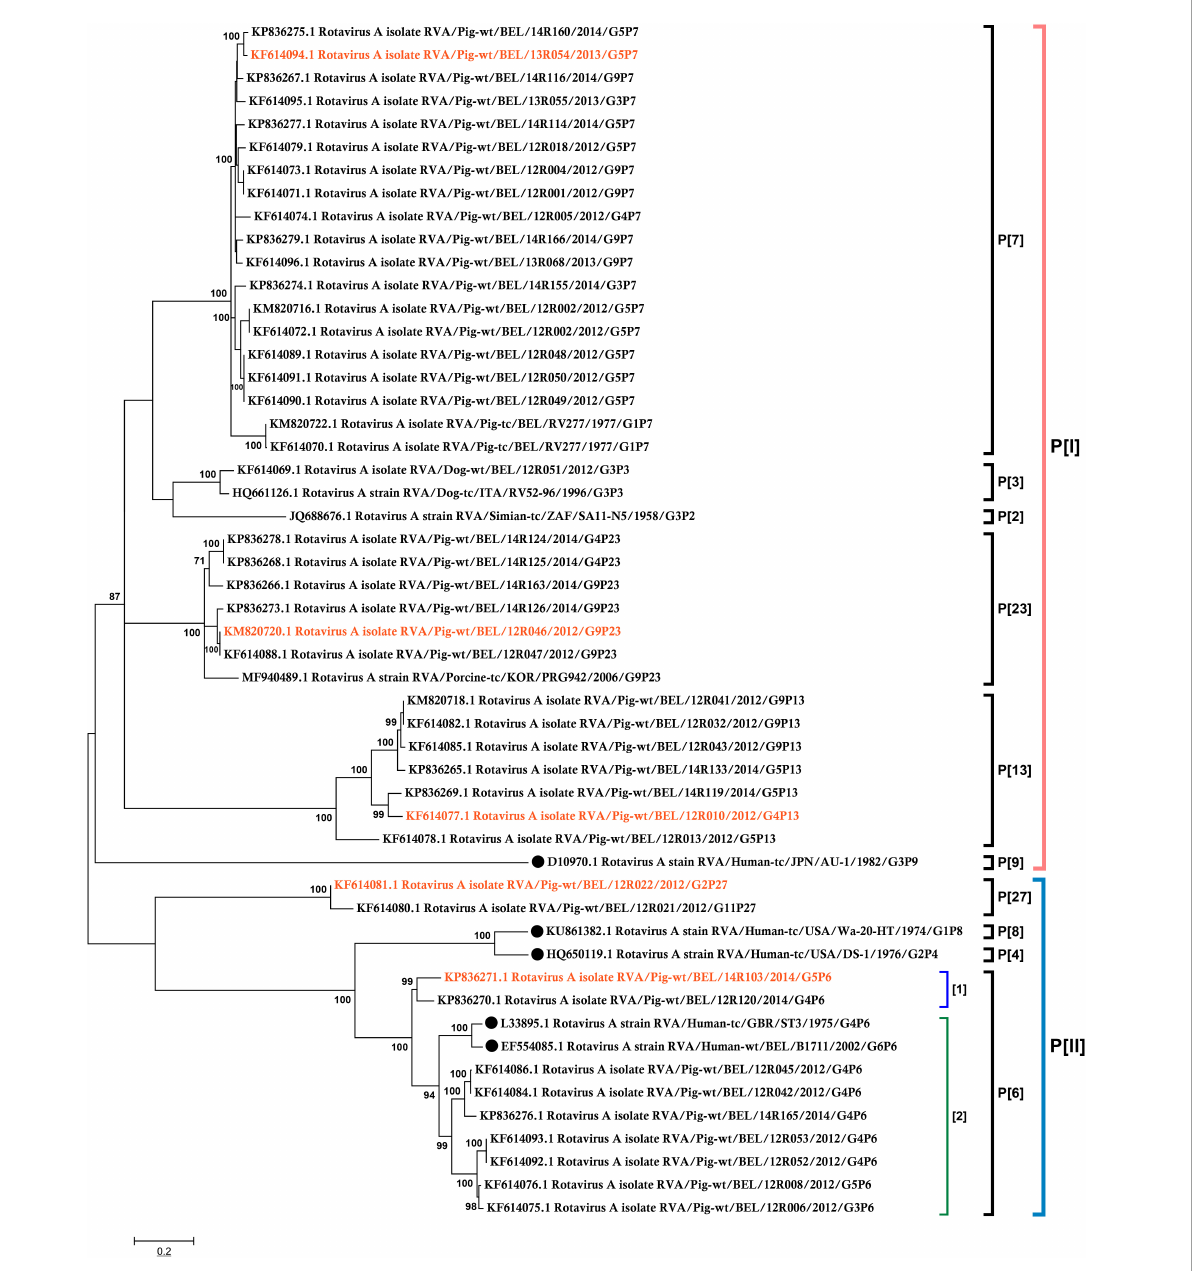
FIGURE1 Phylogenetic tree of rotavirus VP8 ∗ genes of 48 Belgian porcine RVAs and 5 related human RVAs (indicated by a black dot). The phylogenetic tree was constructed based on the VP8 ∗ sequences using the Maximum-likelihood method with bootstrap 500. The bootstrap cutoff value for each clade under 70 is not shown. The red marked RVAs were selected to produce recombinant VP8 ∗ .